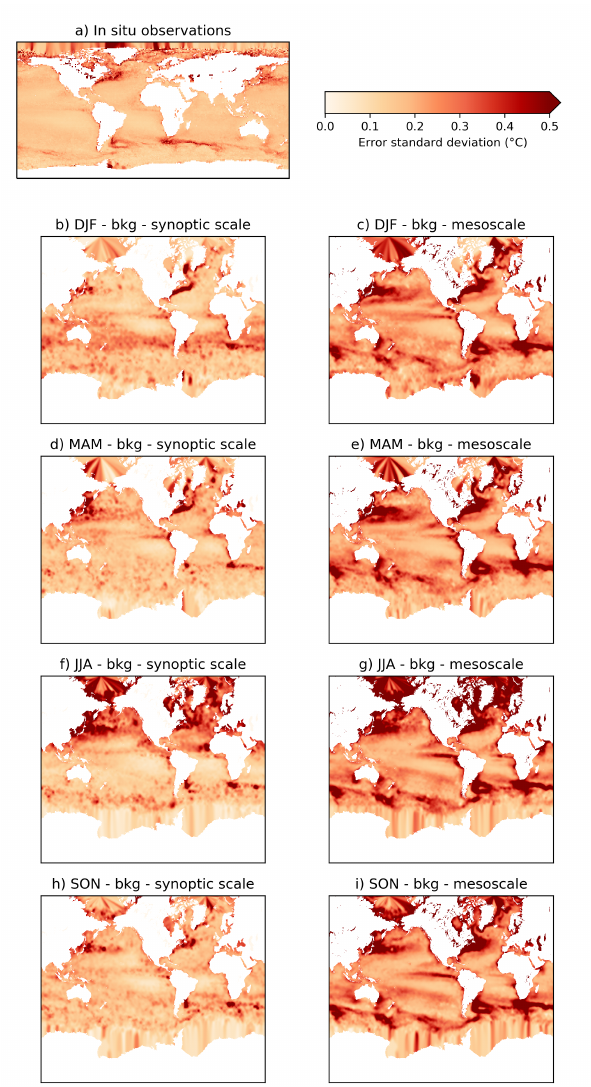
Figure 8. Error standard deviations used for the SST and observation influence analyses: ( a ) observation error standard deviation used for in situ observations; ( b ) the component of the background (bkg) errors that is correlated on synoptic scales in the December-January-February season and ( c ) the component that is correlated at mesoscales. ( d , e ) as ( b , c ) except for March-April-May; ( f , g ) as ( b , c ) except for June-July-August; and ( h , i ) as ( b , c ) except for